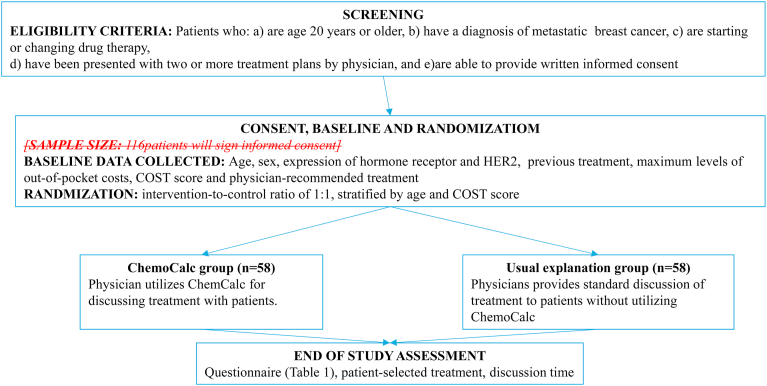
Study flow diagram.